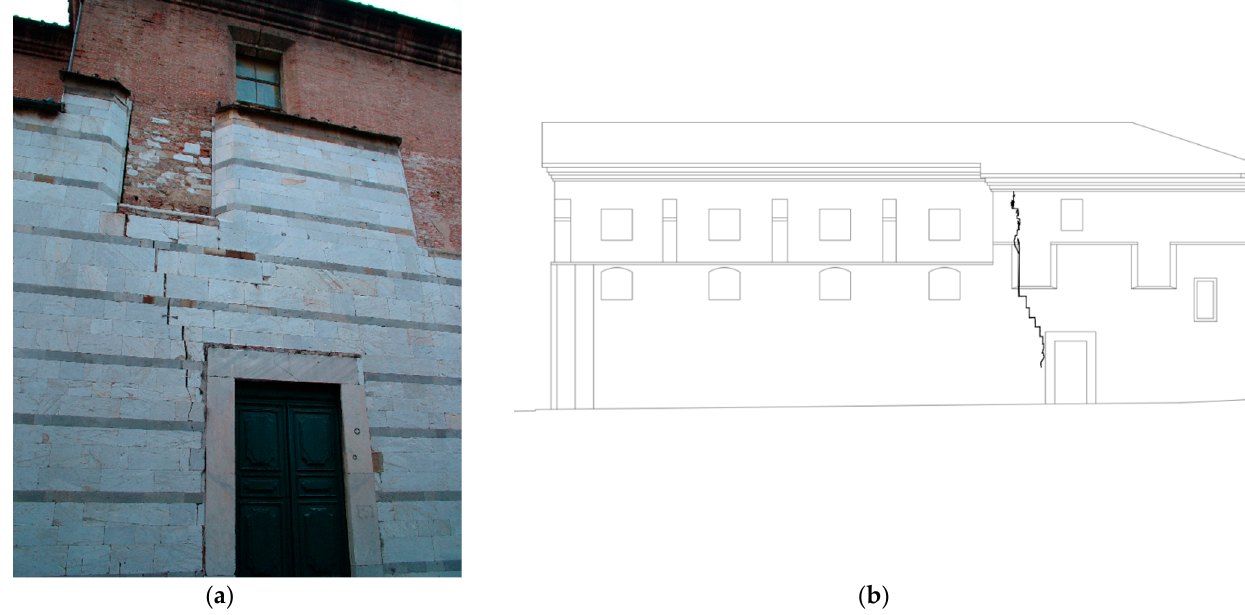
Figure 19. The crack pattern on the south façade: ( a ) detail; ( b ) graphical representation.